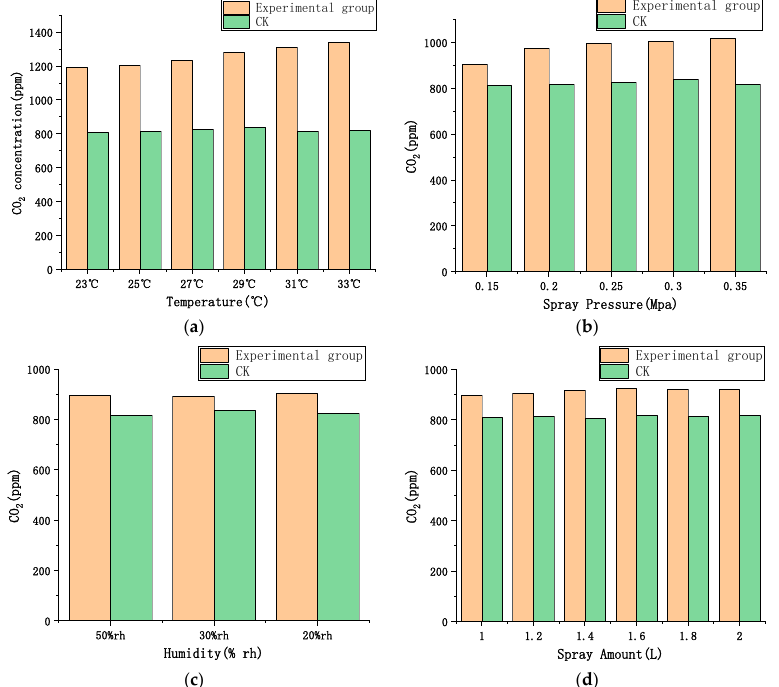
Figure 15. Histogram of the effect of different influencing factors on the concentration of CO 2 micro/nanobubbles. ( a ), ( b ), ( c ), and ( d ) represent the bar charts of CO 2 concentration in the experi- mental environment with the change of ambient temperature, spraying pressure, ambient humidity, and spraying amount, respectively.